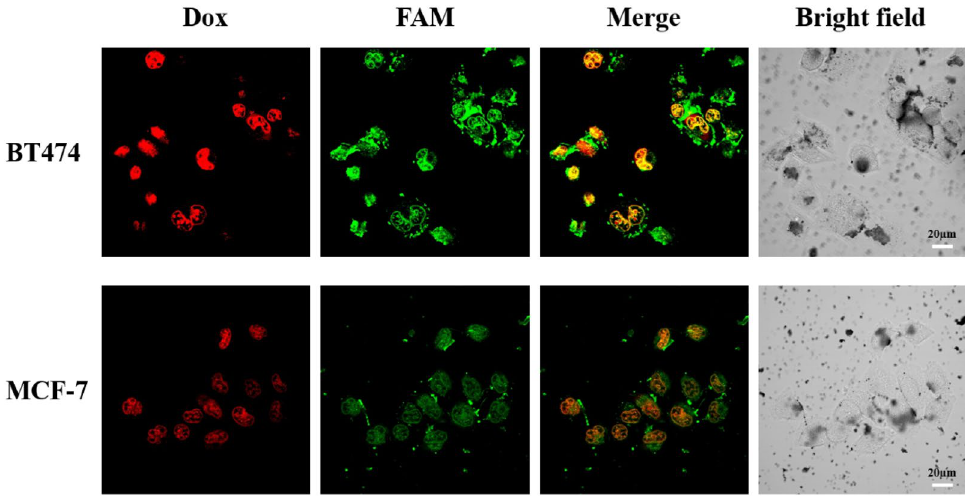
Figure 5. LSCM images of BT474 and MCF-7 cells incubated with Dox@affi-F/AuNPs. BT474 and MCF-7 cells were treated with FAM-labelled Dox@affi-F/AuNPs for 2 h (relative FAM = 5 µM). The red fluorescence was arisen from Dox (ex/em, 488/575 nm), and the green fluorescence was arisen from FAM (ex/em, 494/522 nm). Scale bar: 20 µm.